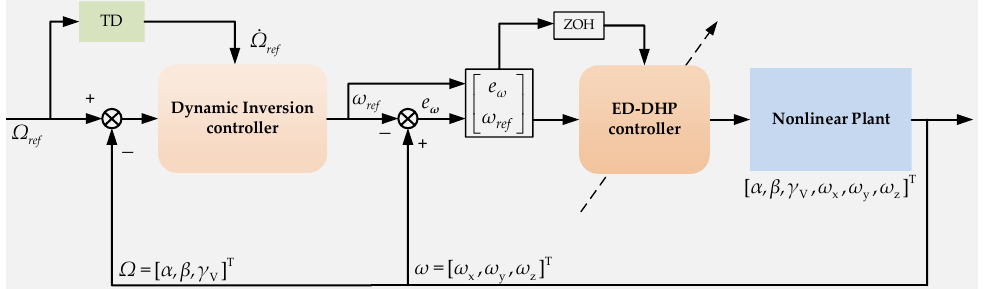
Figure 1. Schematic of flight controller with ED-DHP.